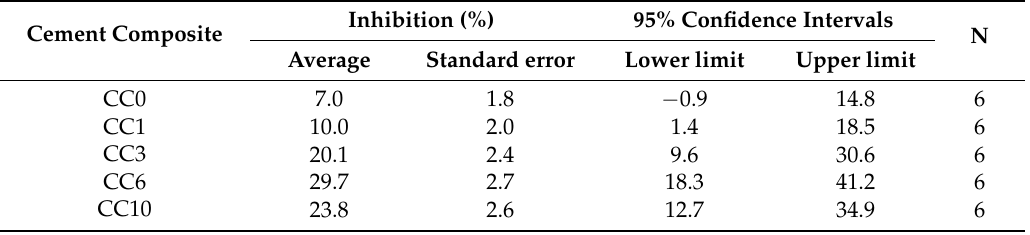
Table 9. Basic statistical characteristics of test results of root growth inhibition of Sinapis alba.